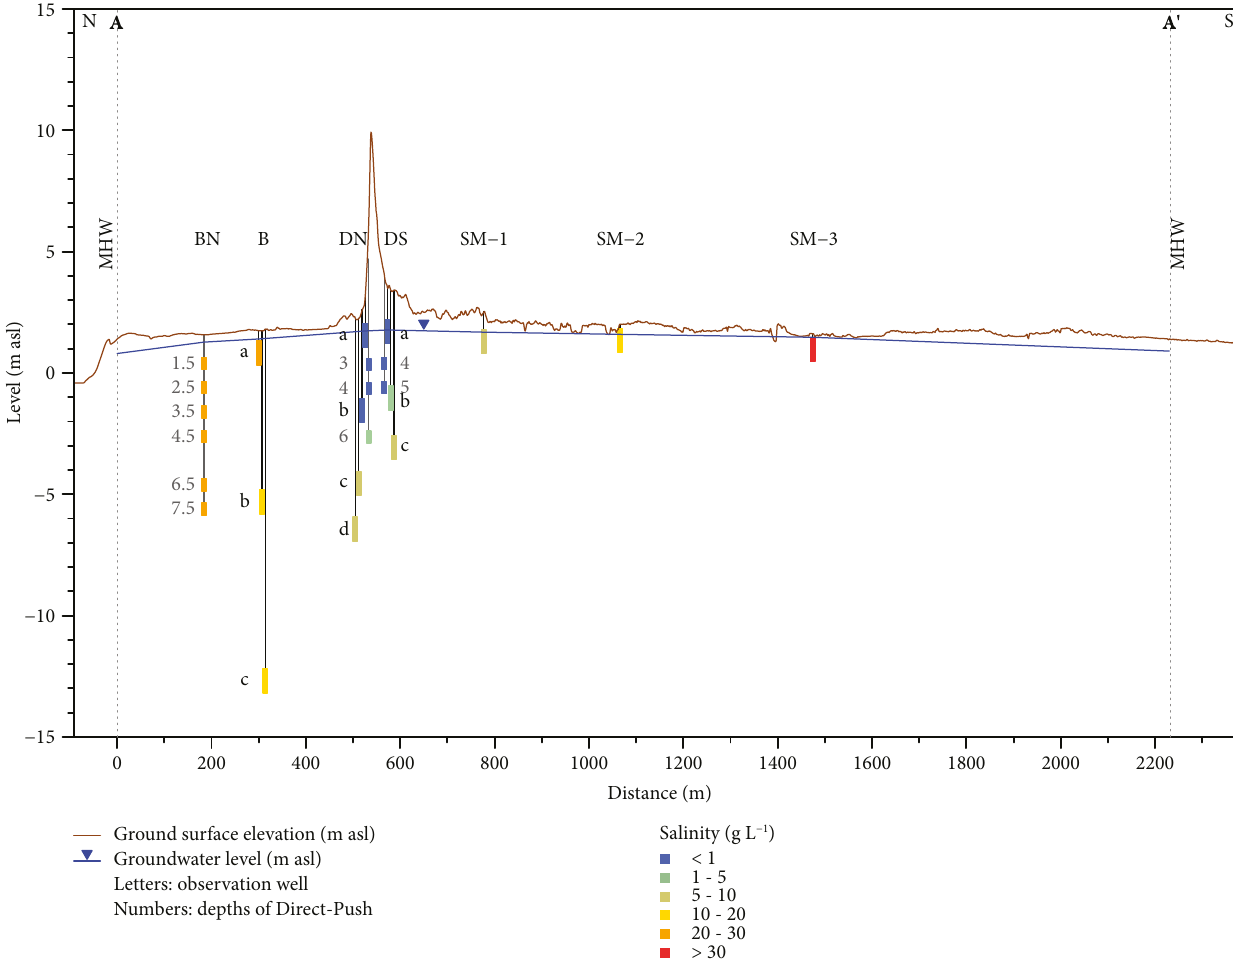
Figure 2: Location and mean screen depths of the OWs (marked with letters in black) and the Direct-Push drillings (depths marked with numbers in grey). Groundwater salinities measured in September 2016 are shown. The groundwater level (blue line) in this and following fi gures corresponds to the mean point water head between April 2016 and December 2016 (period without storm tides). The distance ( x -axis) in this and following fi gures refers to the distance between the MHW-mark north of the dunes ( distance = 0 m ) and the MHW-mark south of the dunes. The level in m asl ( y -axis) in this and following fi gures is equivalent to height above vertical datum